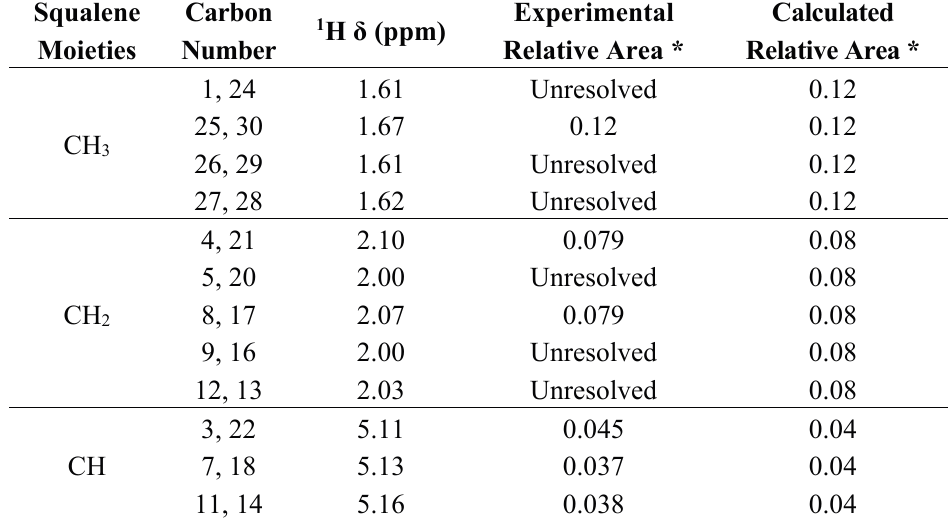
Figure 2. 1 H NMR spectra of tear lipids extracted from (i) Schirmer’s strip tear extracts (SSTE) or (ii) SQ. ( A ) =CH region; and ( B ) CH 3 , CH 2 region. Numbers are the carbon numbers for SQ (Figure 1) assigned to the resonances. Table 1. Relative areas of 1 H NMR resonances in the spectrum of Schirmer’s strip tear extracts